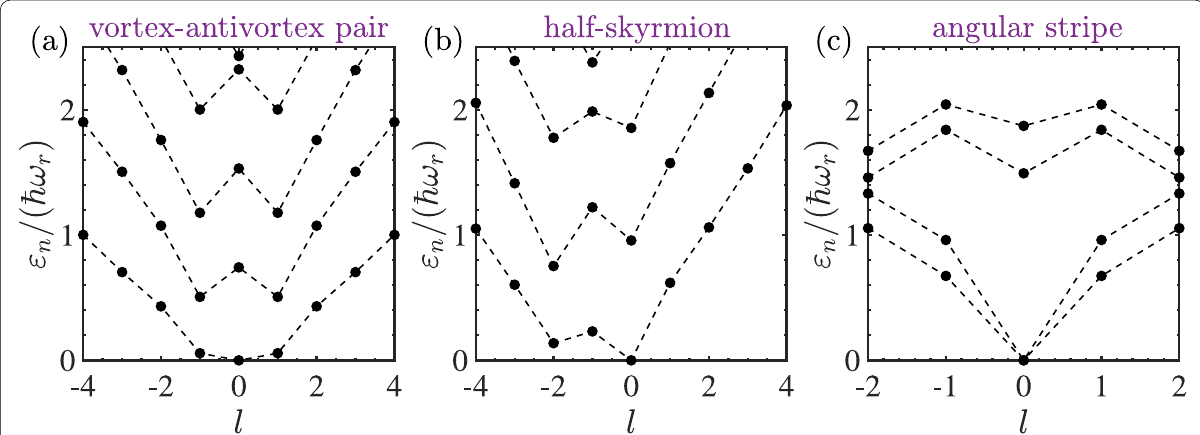
Fig. 6 Excitation spectrum as a function of the quasi‑angular momentum l of Bogoliubov quasiparticles in three typical ground‑state phases, i.e., a vortex‑antivortex pair phase, b half‑skyrmion phase, and c angular stripe phase. The figures are remade based on data in Refs. [60, 61]